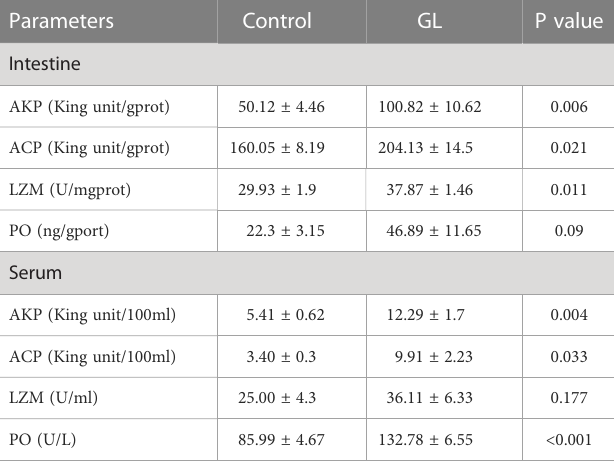
TABLE 4 The effects of b -1,3-glucan on the immunity of Litopenaeus vannamei . Parameters